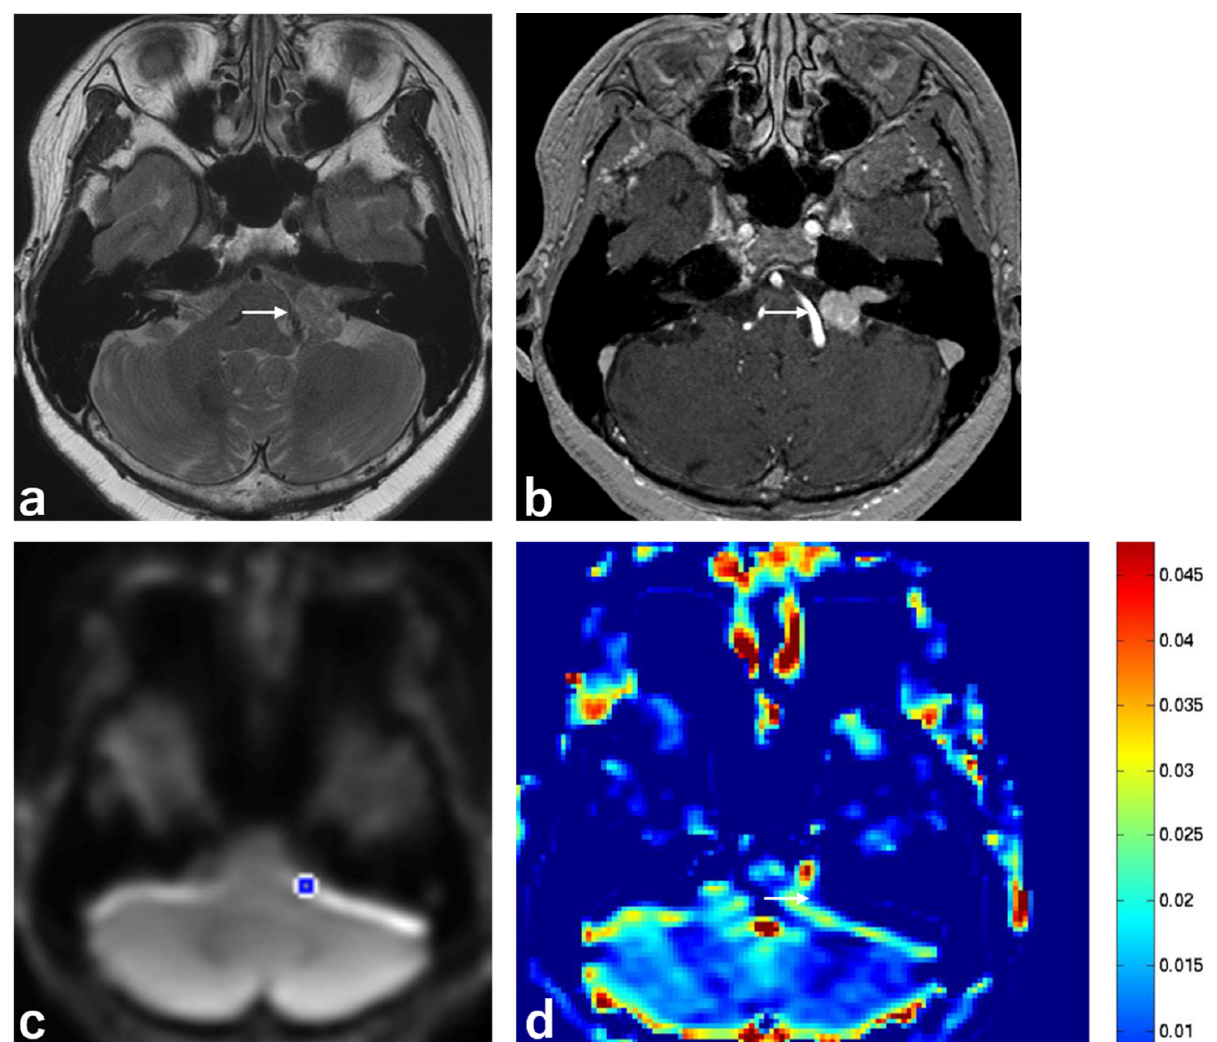
Figure 2. Imaging from a 66-year-old woman with a schwannoma with T2 low intensity. ( a ) MRI, T2 sequence, axial section, showing homogeneous low intensity in a schwannoma in the left CPA (white arrow). ( b ) MRI, 3D contrast-enhanced T1 sequence, axial section, showing homogeneous enhancement in a schwannoma in the left CPA (white arrow). ( c ) MRI, APT-CEST scout image, axial section, showing the ROI (blue circle) in a schwannoma in the left CPA. ( d ) MRI, APT-CEST sequence, axial section, showing low SI in a schwannoma in the left CPA (white arrow).